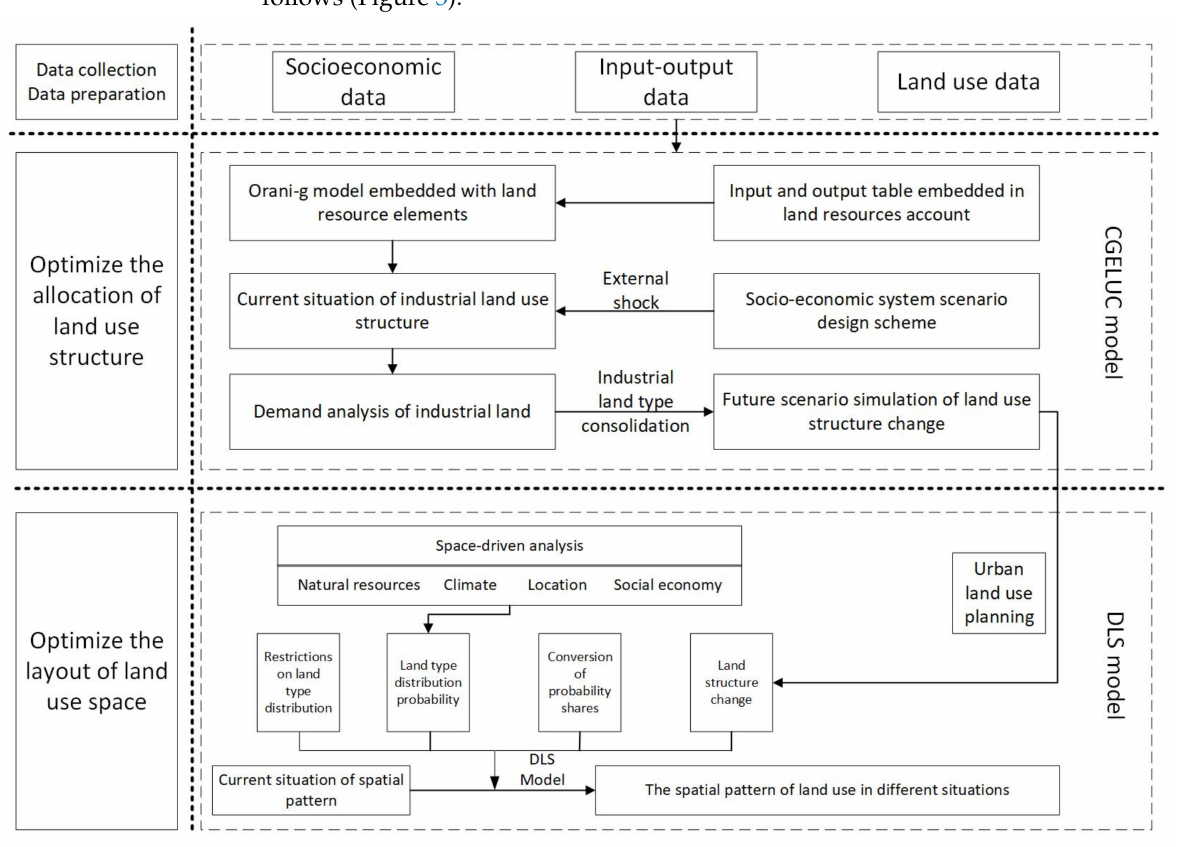
Figure 3. Research